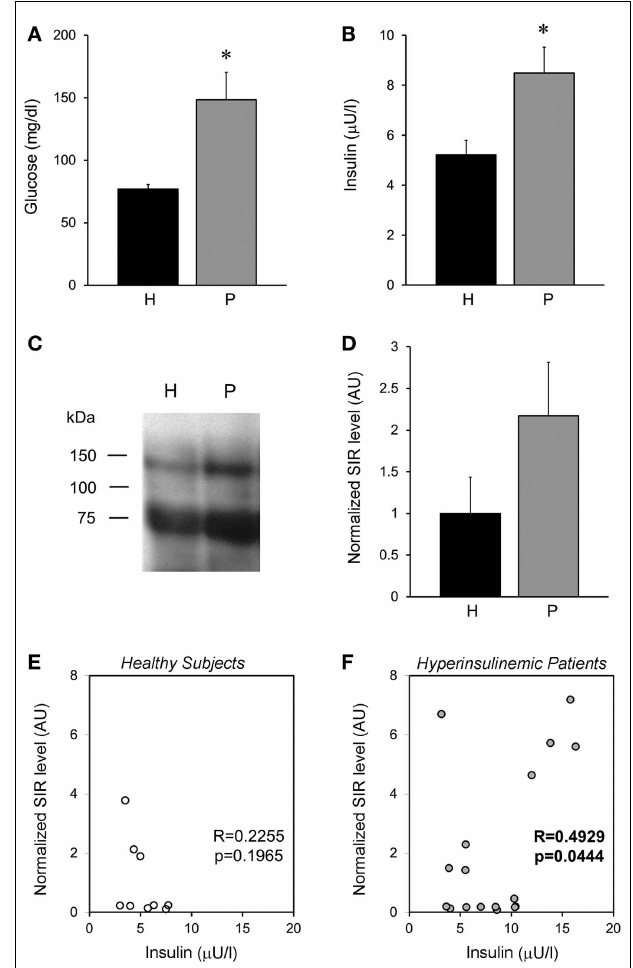
FIGURE 9 | Plasma SIR is detected in healthy and diabetic patients . (A) Fasting plasma glucose levels and (B) insulin, from healthy subjects (H) and patients (P) that present hyperglycemia and hyperinsulinemia. (C) RepresentativeWestern blots of alpha-IR immunoprecipitated plasma from healthy subjects and hyperglycemic–hyperinsulinemic patients. Note that alpha-IR immunoblotting appears in two bands (close to the expected size for α -IR monomer: 135kDa, and a fragment around 75kDa) of a SDS-PAGE gel. (D) A tendency of higher SIR levels is observed in the plasma of hyperglycemic–hyperinsulinemic patients. SIR levels were determined by densitometry of the experiments depicted in (D) and normalized with respect to the average level of healthy subjects. (E,F) Show the correlation between the normalized SIR levels and the plasmatic insulin, which resulted significant for patients. Bars represent mean ± SEM of healthy subjects ( N = 9) and hyperglycemic–hyperinsulinemic patients ( N = 17), * p <